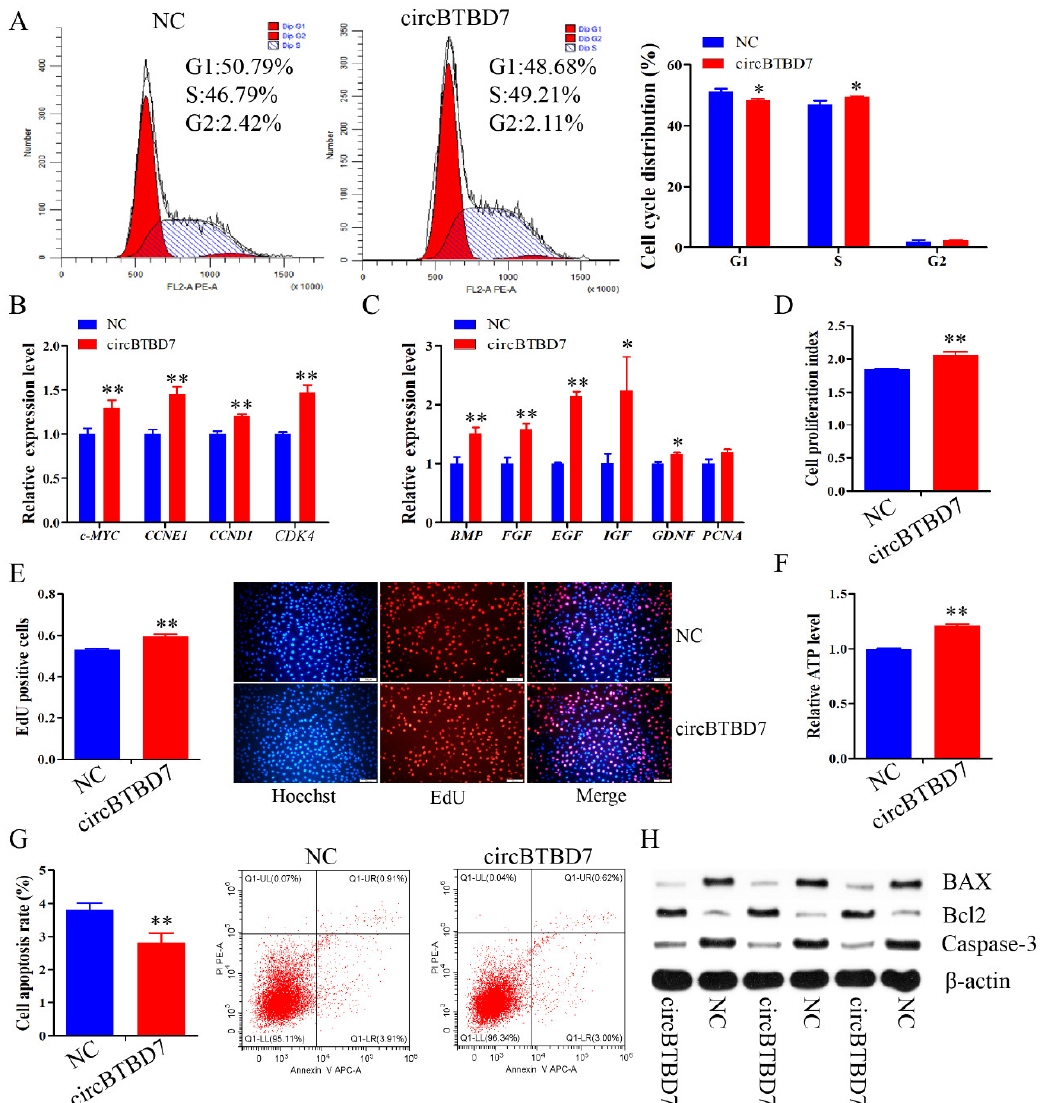
Figure 2. circBTBD7 promotes proliferation and inhibits apoptosis of immature porcine Sertoli cells. Immature porcine Sertoli cells were transfected with circBTBD7 overexpression vector or blank vector (NC). ( A ) The cell cycle distribution was analyzed using a FACSCanto II flow cytometer, and then the proportion of cells in G1, S, and G2 phases were counted ( n = 3). ( B , C ) The mRNA expression of cell cycle-related genes ( B ) and cell proliferation marker genes ( C ) was measured using the qRT-PCR assay ( n = 3). The pig-TBP gene was used as the internal control. ( D ) CCK-8 was used to explore the effect of circBTBD7 on the cell proportion index ( n = 3). ( E ) The cell mitosis activity was checked using the EdU incorporation assay ( n = 3). Representative images of EdU staining are listed. Scale bar = 200 μm. ( F ) The effect of circBTBD7 on the relative ATP level ( n = 3). ( G ) The cell apoptosis rate was investigated using Annexin V-FITC/PI staining assay ( n = 3). ( H ) The protein expression of cell survival-related geneswas determined using Western blot assay ( n = 3). The β-actin gene was used as the internal control. Data are presented as the mean ± S.D. * p < 0.05, ** p < 0.01.